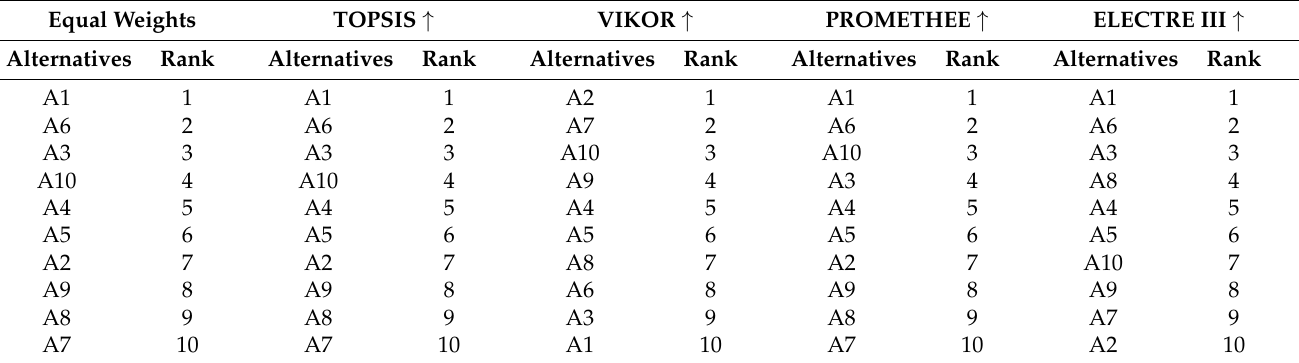
Table 8. The priority of project selection by considering different priorities in different